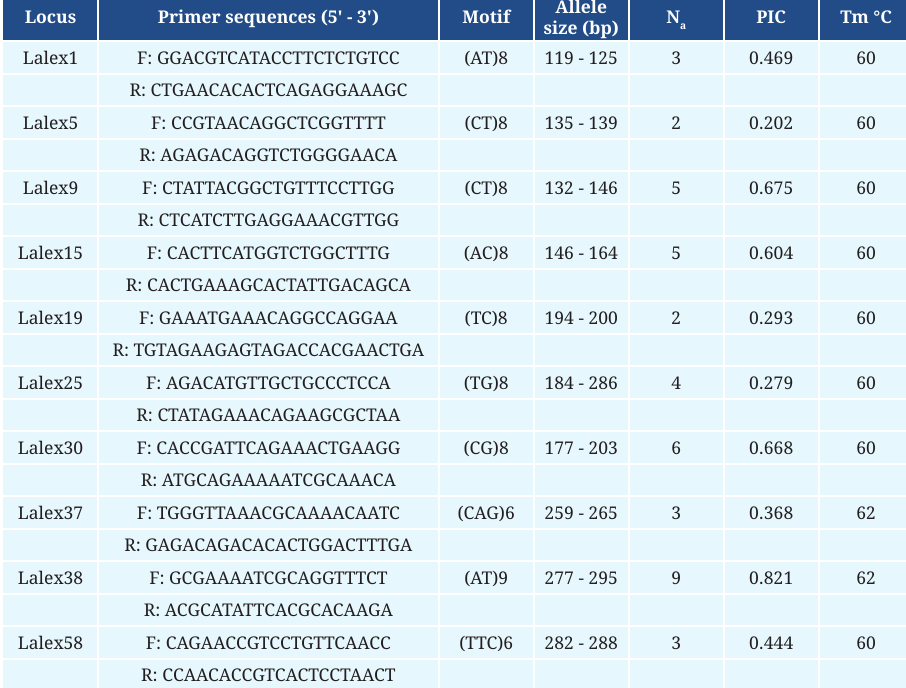
TABLE 1 | Characteristics of the ten polymorphic microsatellite markers of Lophiosilurus alexandri . N number of alleles; PIC - polymorphism information content; Tm °C melting